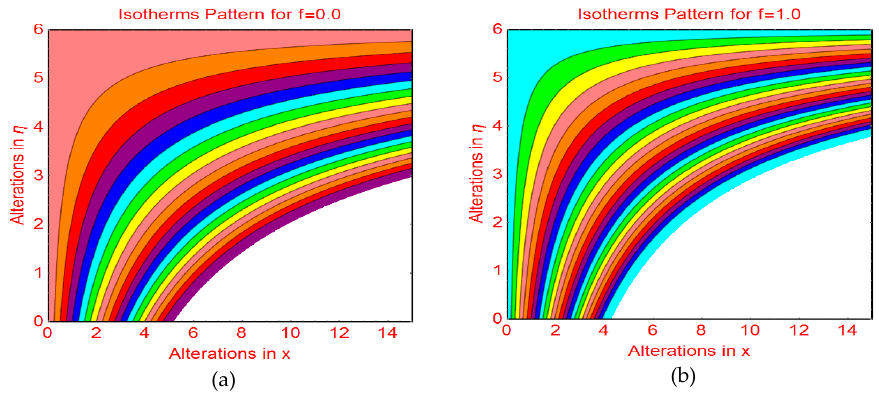
Figure 10. Streamlines profile for 𝑓1 = −1.0